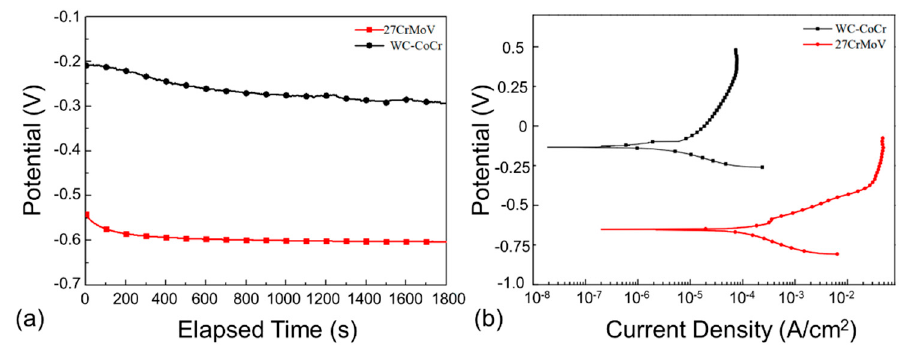
Figure 5. ( a ) Time dependence of open-circuit potentials and ( b ) potentiodynamic polarization curves of the 27CrMoV substrate and WC–10Co4Cr coatings measured in saturated saline solution.